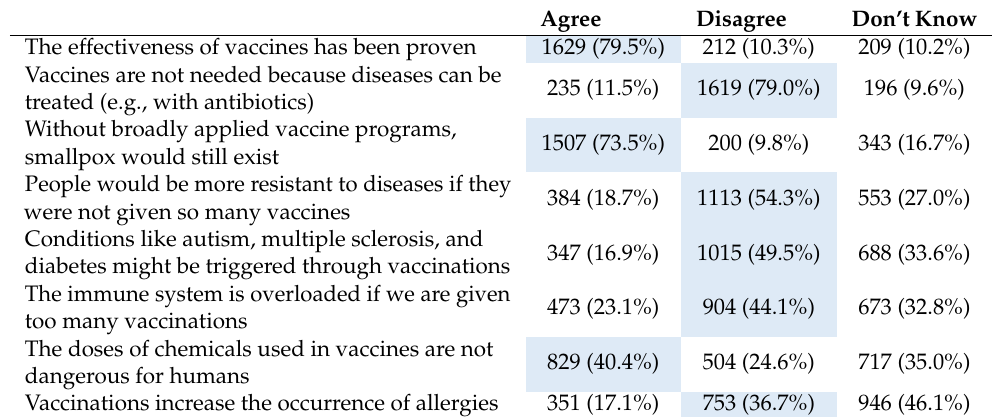
Table 7. General vaccine knowledge—Shading indicates correct response.